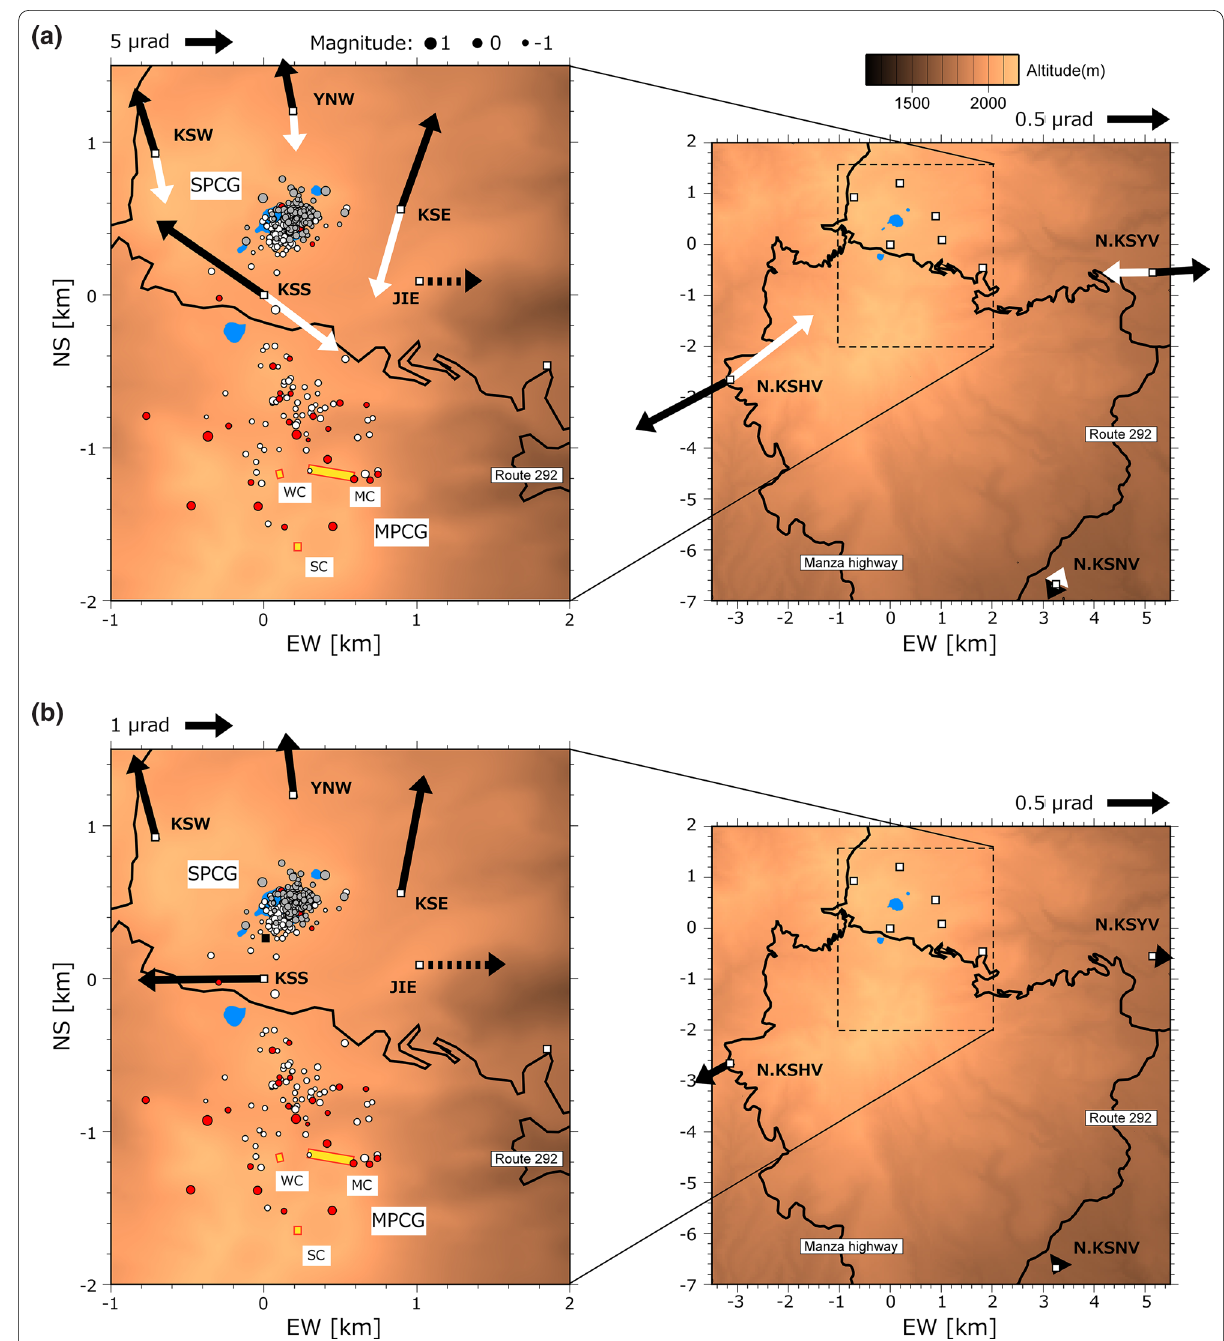
Fig. 4 Tilt vectors in the study area. Yellow rectangles show the localities of vents formed during the 2018 eruption. White, red, and gray circles represent hypocenters for the periods from 1 January 2016 to 22 January 2018 (before the eruption), from 23 January to 22 April 2018 (after the eruption), and from 22 to 23 April 2018 (representative of SPCG unrest in 2018), respectively, as determined by the Kusatsu–Shirane Volcano Observatory, Volcano Fluid Research Center, Tokyo Institute of Technology. a Phase 1 (black arrows, Fig. 3) and phase 2 (white arrows, Fig. 3). b First half of phase 1 (black arrows; 10:00–10:01 JST). Note that the vector scale is different from that in Fig.